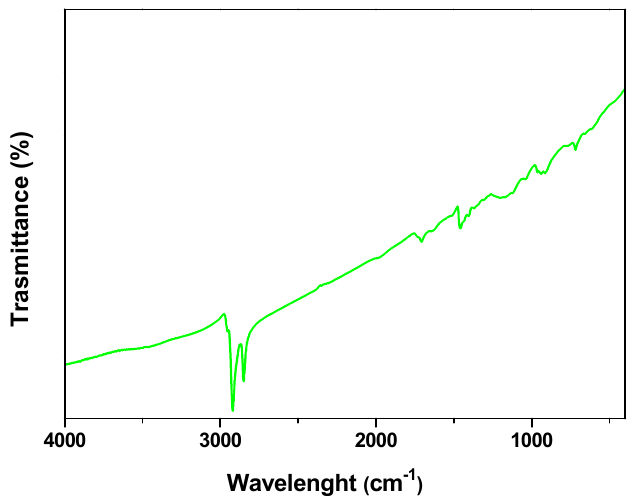
Figure 2. FT-IR spectrum of the so-prepared nanoparticles.